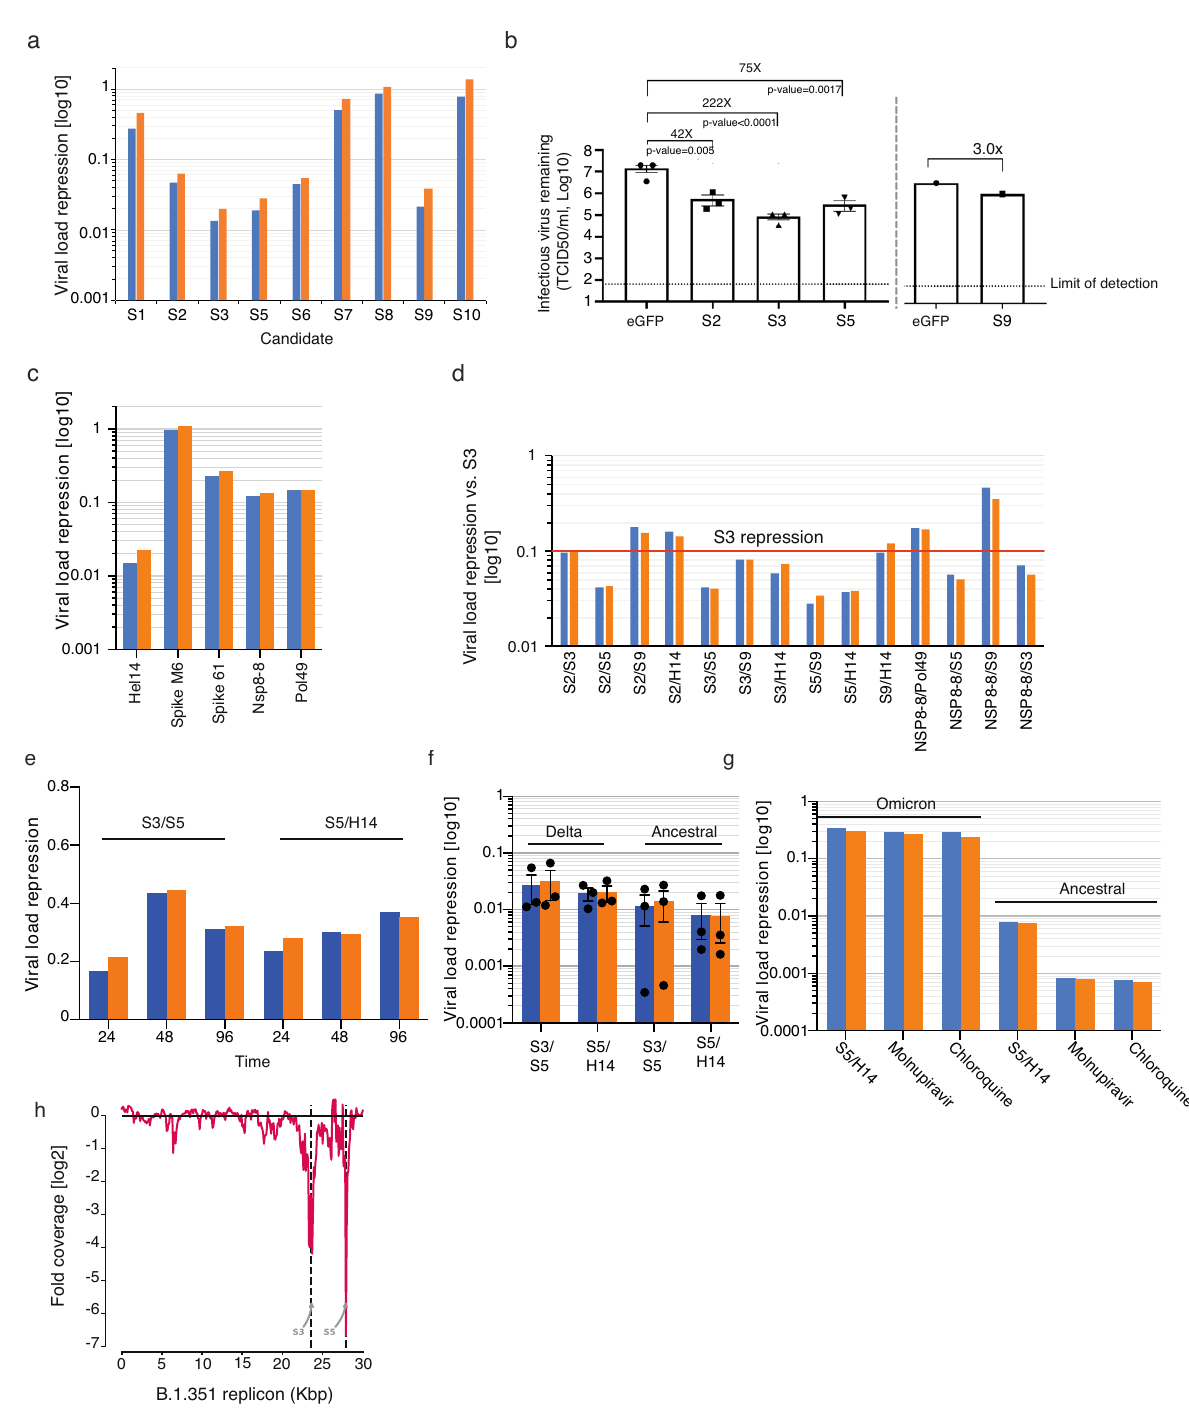
Fig. 3 siRNAs repress live SARS-CoV-2 replication in VeroE6 cells. Blue and orange: qPCR results of the E and RdRP transcripts, respectively. Unless noted otherwise, the 100% viral load was calibrated to viral level after treatment with an anti-GFP siRNA. a Viral load of SARS-CoV-2 (ancestral strain) after treatment with the top siRNA candidates from the Sens.AI screen; b TCID 50 levels of SARS-CoV-2 (ancestral strain) after treatment with four of the top siRNA molecules. In each batch of the experiments, an siRNA against eGFP was used as a negative control (left panel n = 3, right panel n = 1, error bars = SEM, signi fi cance was calculated using t-test); c Viral load of SARS-CoV-2 (ancestral strain) after treatment with the top siRNA from the bioinformatic pipeline; d The effect of various siRNA cocktails against SARS-CoV-2 (ancestral strain). The results were calibrated to the repression of S3 at the same concentration; e Viral load of SARS-CoV-2 (ancestral strain) after treatment with siRNA cocktails in ALI culture. Viral load was measured in media collected from the media at 48, 72 and 96 hours postinfection ( n = 2 independent samples, error bars = SEM). f Viral load post-treatment with siRNA cocktails against SARS-CoV-2 Delta versus the ancestral strain ( n = 3 independent samples, error bars = SEM). g Viral load of SARS-CoV-2 Omicron versus the ancestral strain after treatment with the S5/Hel14 cocktail and other types of antivirals; ( h ) DeSEQ2 analysis of SARS-CoV-2 replicon treatment with the S3/S5 siRNA cocktail. We observed a sharp coverage decrease around the S3 (~23.5kbase) and S5 (~28kbase) cleavage sites along the replicon sequence (FDR values 4 × 10 − 83 and 6 × 10 − 22 , respectively). Error bars in panels e - f represent standard diviation, based on three